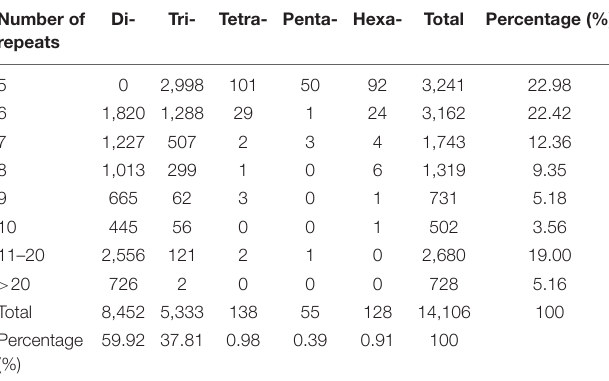
Supplementary Tables 5 , 6 . A total of 182,868 transcripts (mean length 486 bp) representing 111,709 unigenes were